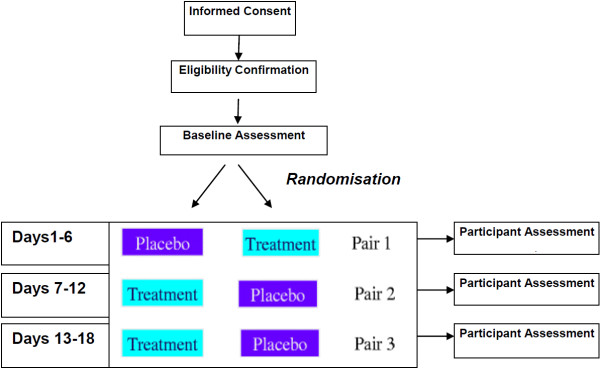
Example of n-of-1 design schema1.